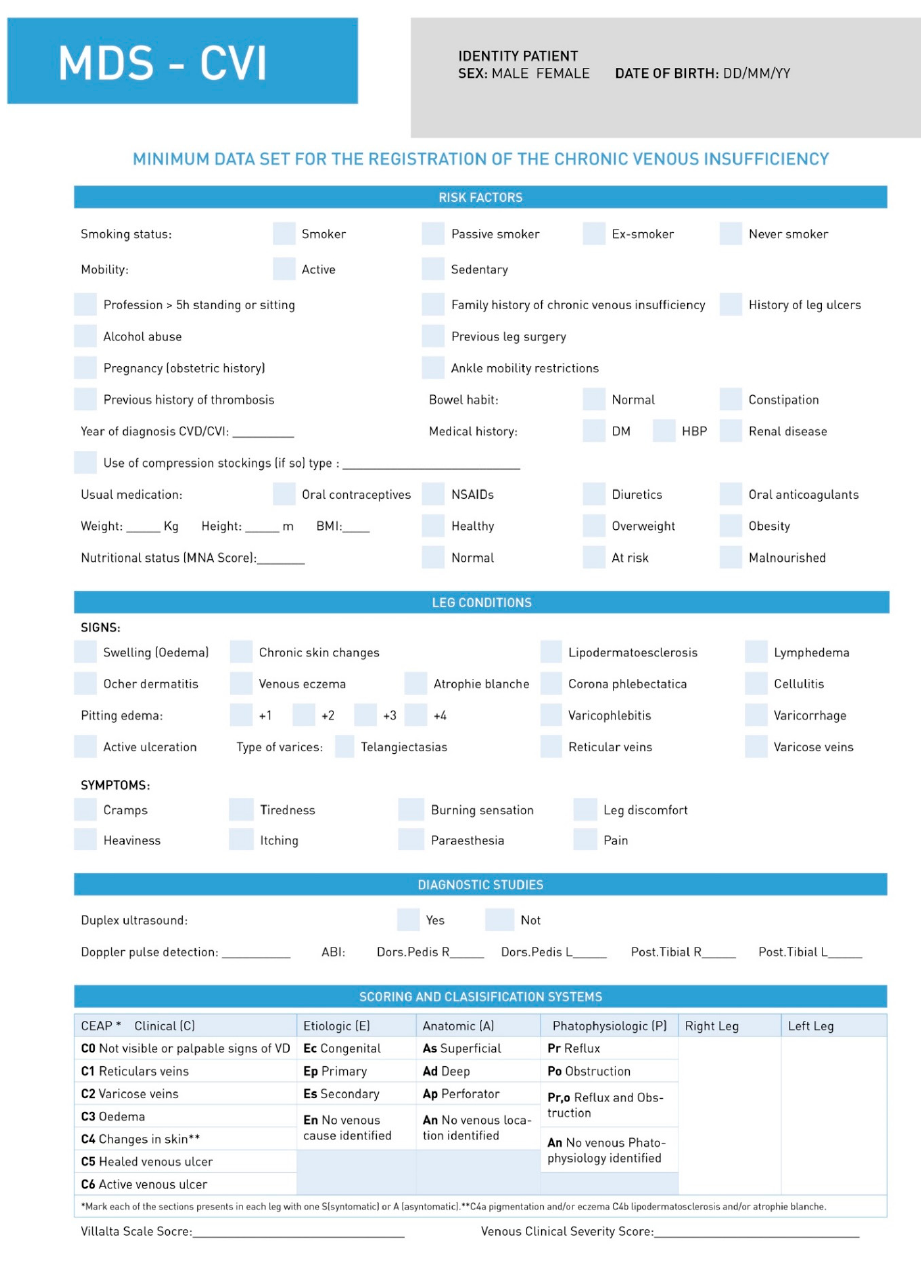
Figure 2. First page of the MSD-CVI.